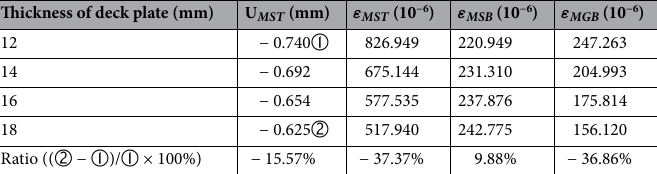
Thickness of deck plate (mm)